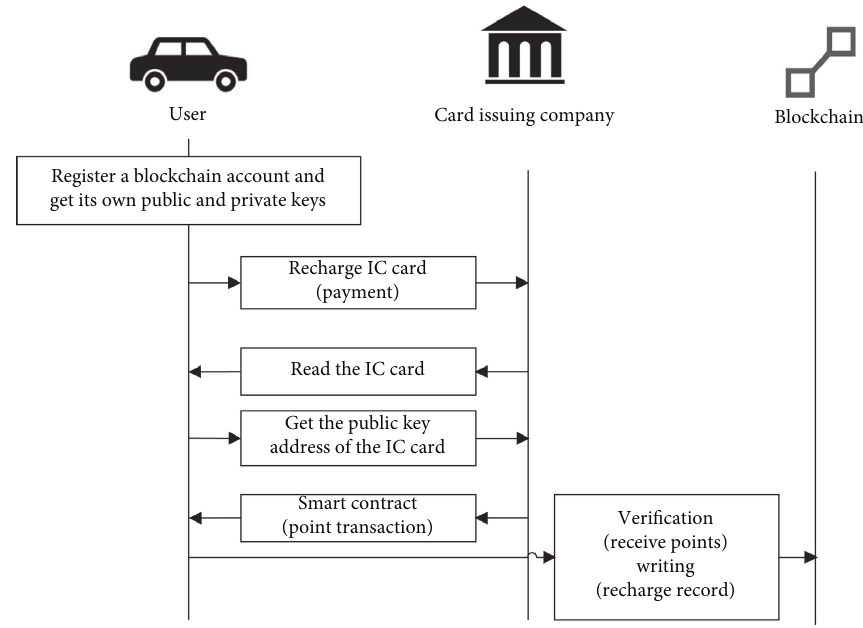
Figure 5: Point transaction between user and card issuing company.